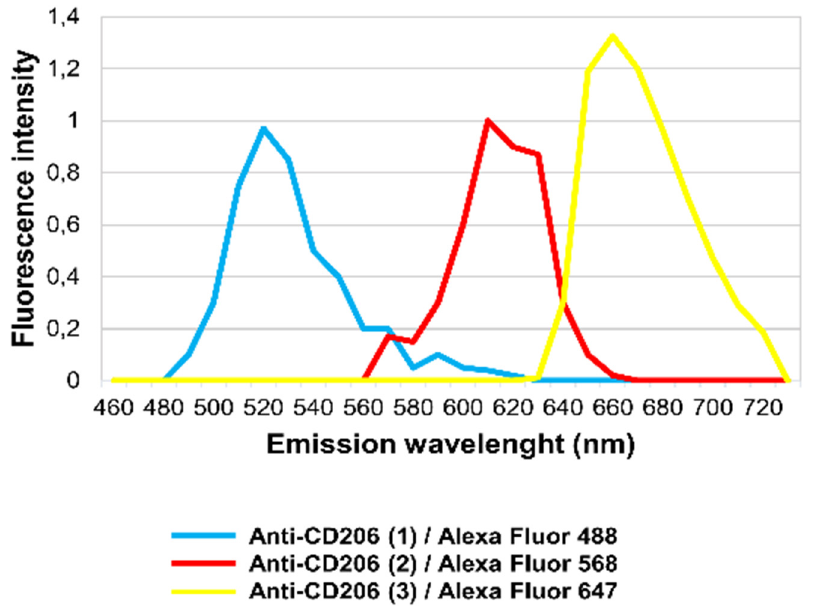
Figure 3. In situ fluorescence microspectroscopy analysis of the Anti-CD206 (1, 2, 3) antibodies in IR-ASC muscle. Emission spectra of Anti-CD206 (1)/Alexa Fluor 488 (turquoise line), Anti-CD206 (2)/Alexa Fluor 568 (red line) and Anti-CD206 (3)/Alexa Fluor 647 (yellow line).